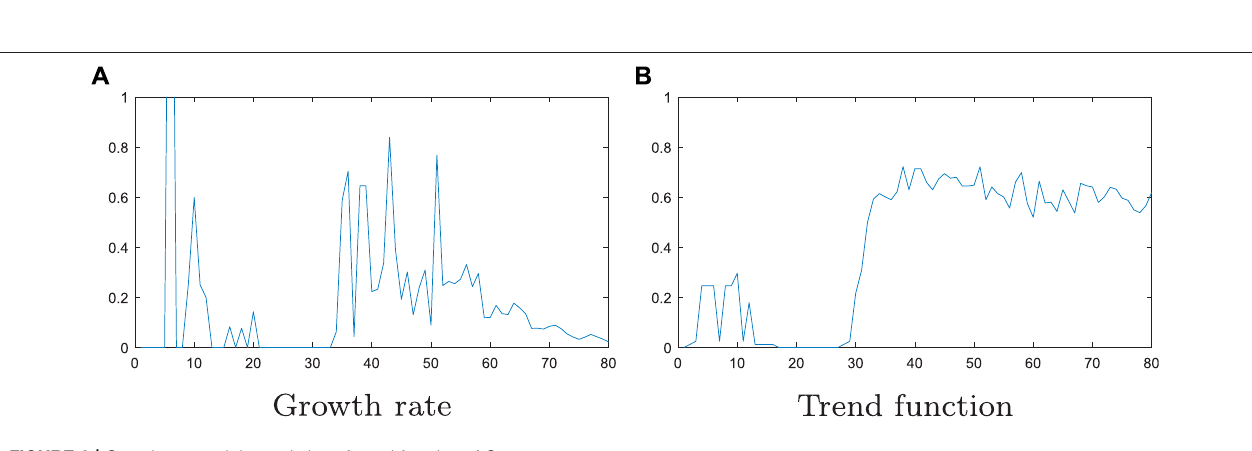
FIGURE 3 | Growth rate and the evolution of trend function of